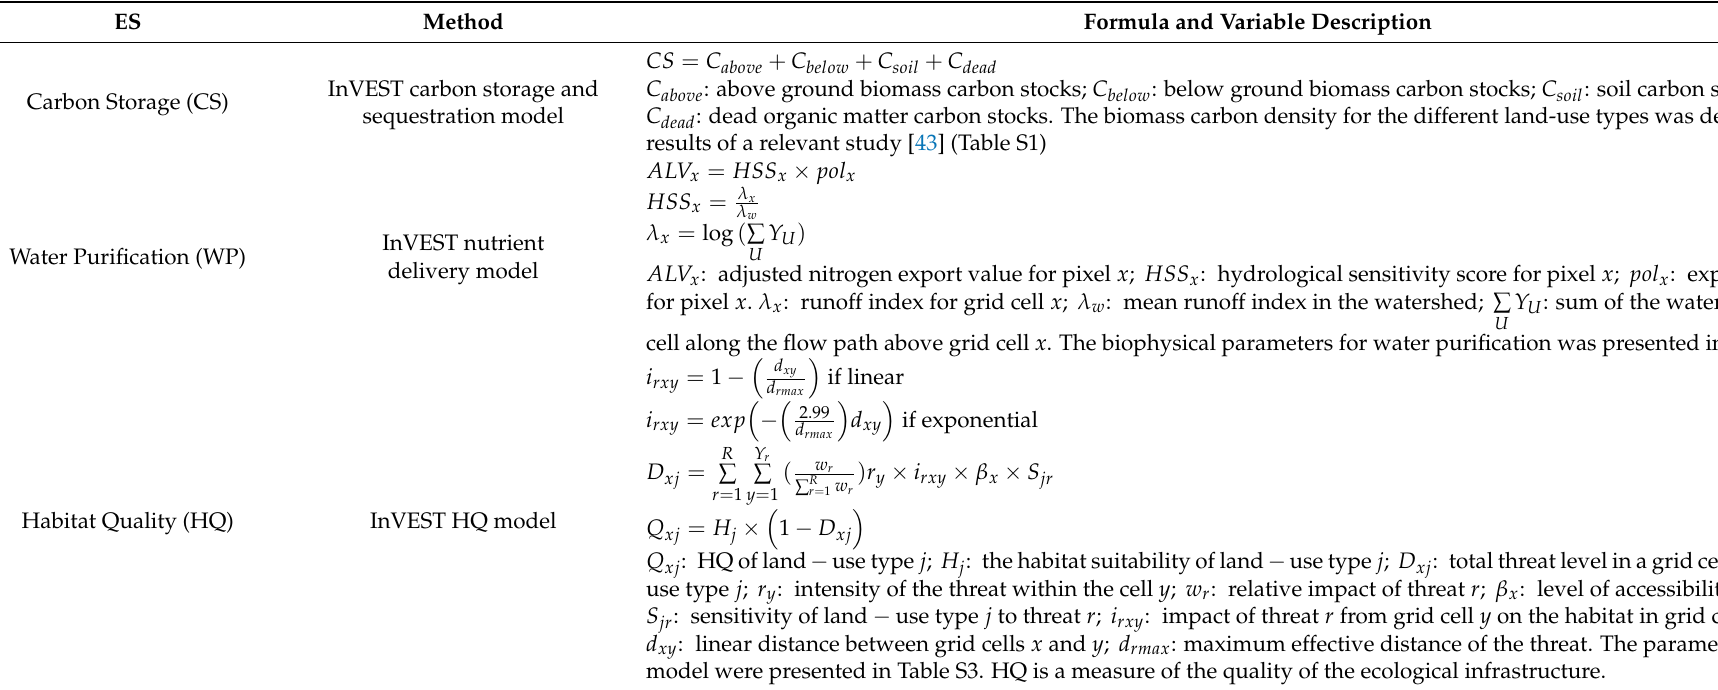
Table 1. Methods and calculations used to estimate the